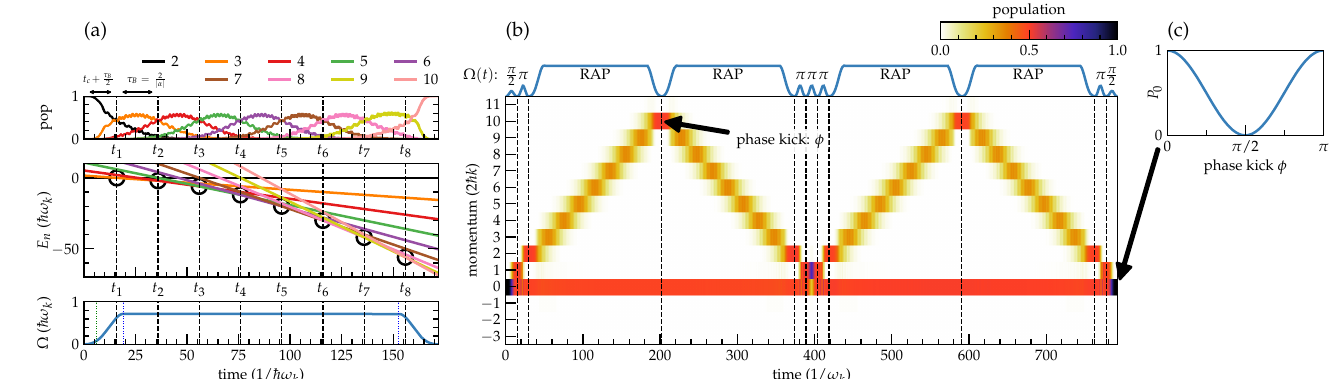
Figure 3. ( a ) Transfer of population from momentum state 2 to 10 using rapid adiabatic passage | (cid:105) | (cid:105) (RAP) with a constant linear chirp rate α = 0.1 ω k with an offset time of t c = 5.93 / ω k in Equation (11) (green dotted line, bottom). The pulse envelope Ω ( t ) , shown in the bottom of panel ( a ), has a switch-on and switch-off time of t r = 19.25 / ω k (blue dotted line), using half of a Blackman shape. The center of panel ( a ) shows the dynamic energy levels of the Hamiltonian according to Equation (11). α Neighboring levels cross at intervals of τ B = 2/ , resulting in the transfer of population shown | | at the top of panel ( a ). ( b ) Momentum space dynamics for a full interferometric scheme using an initial π /2 and π pulse to achieve momentum state separation, cf. Figure 2. Then, the RAP pulse from panel ( a ) first amplifies and then de-amplifies the momentum state separation. The momentum components are swapped with three central π pulses. In the second half of the scheme, two additional RAP pulses amplify and de-amplify again. Finally, a π and π /2 pulse perform the recombination. The amplitude of the envelope Ω ( t ) in each pulse is drawn to scale at the top of the panel. ( c ) The final time population in 0 , if an instantaneous phase kick is applied to the 10 component of the | (cid:105) | (cid:105) wave function at maximum separation, to account for the free time evolution starting at t = 201.8 / ω k and t = 590.6 / ω k (not